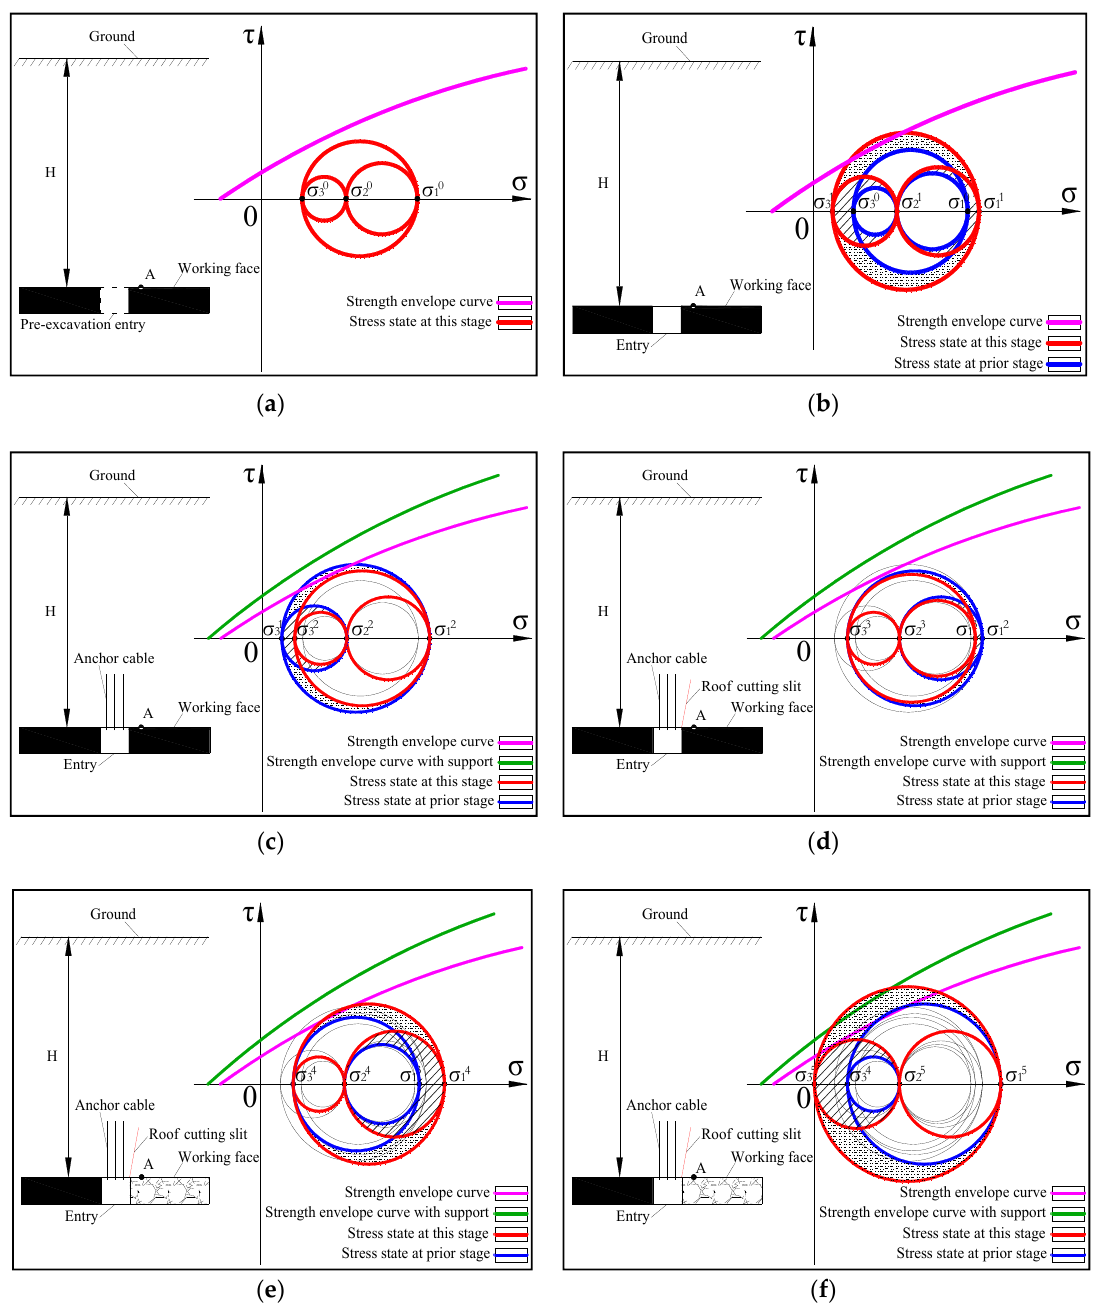
Figure 2. Stress state evolution process of surrounding rock: ( a ) original rock stress state; ( b ) entry excavation stress state; ( c ) bolt-cable support stress state; ( d ) roof cutting stress state; ( e ) premining stress state; ( f ) postmining stress state.